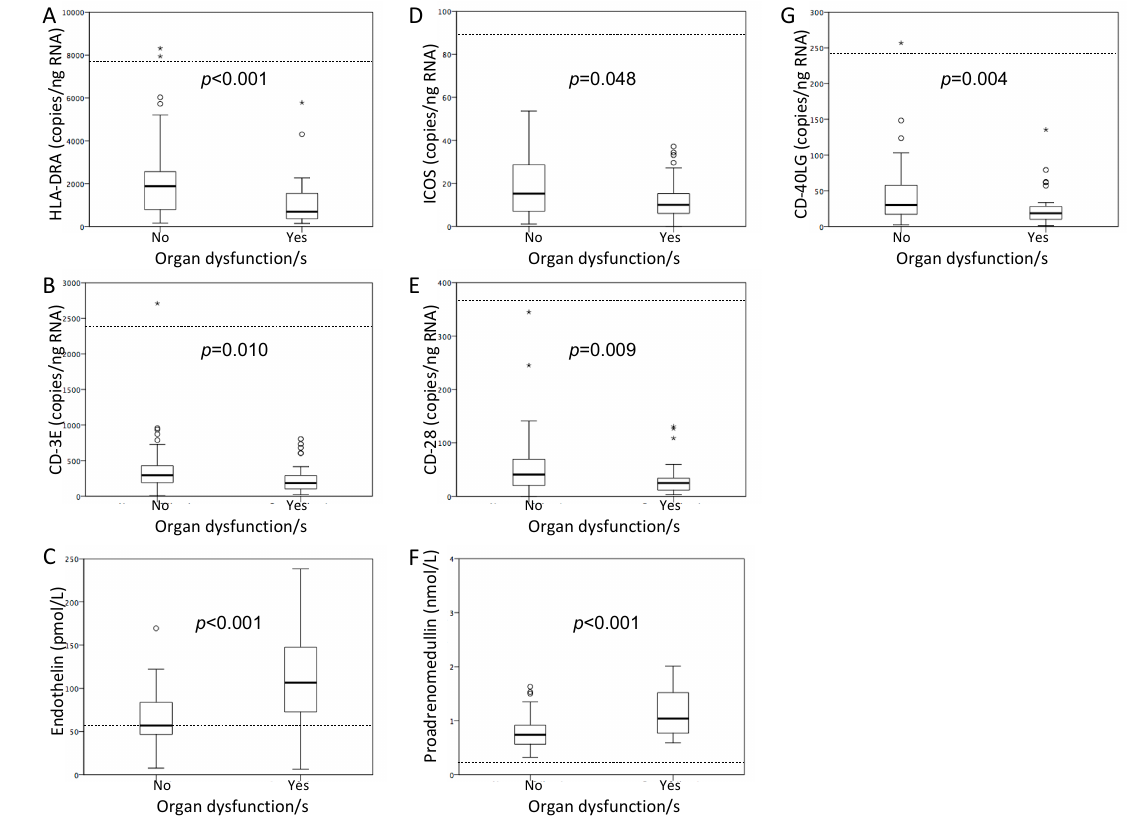
Figure 1. Box plots representing genes expression and biomarker levels according to the presence of organ dysfunction / s. The boxes show the interquartile range and the line inside shows the median. Dashed lines show the median values of the healthy controls. HLA-DRA: histocompatibility complex class II DR alpha; ICOS: Inducible T-cell costimulator; CD40LG: CD40 ligand ( A ) HLA-DRA. ( B ) CD3E. ( C ) Endothelin. ( D ) ICOS. ( E ) CD28. ( F ) Proadrenomedullin. ( G ) CD40LG. For comparison purposes, the Mann–Whitney U test was used. Table 3. Gene expression and biomarkers according to time to clinical stability and length of Table 2. Spearman correlations between genes and biomarkers with CURB65 and oxygen saturation.